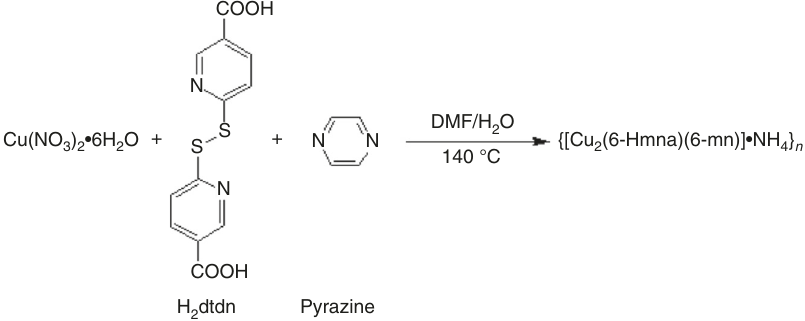
Fig. 1 Synthesis of compound 1 . Synthetic pathway to {[Cu 2 (6-Hmna)(6-mn)]·NH 4 }